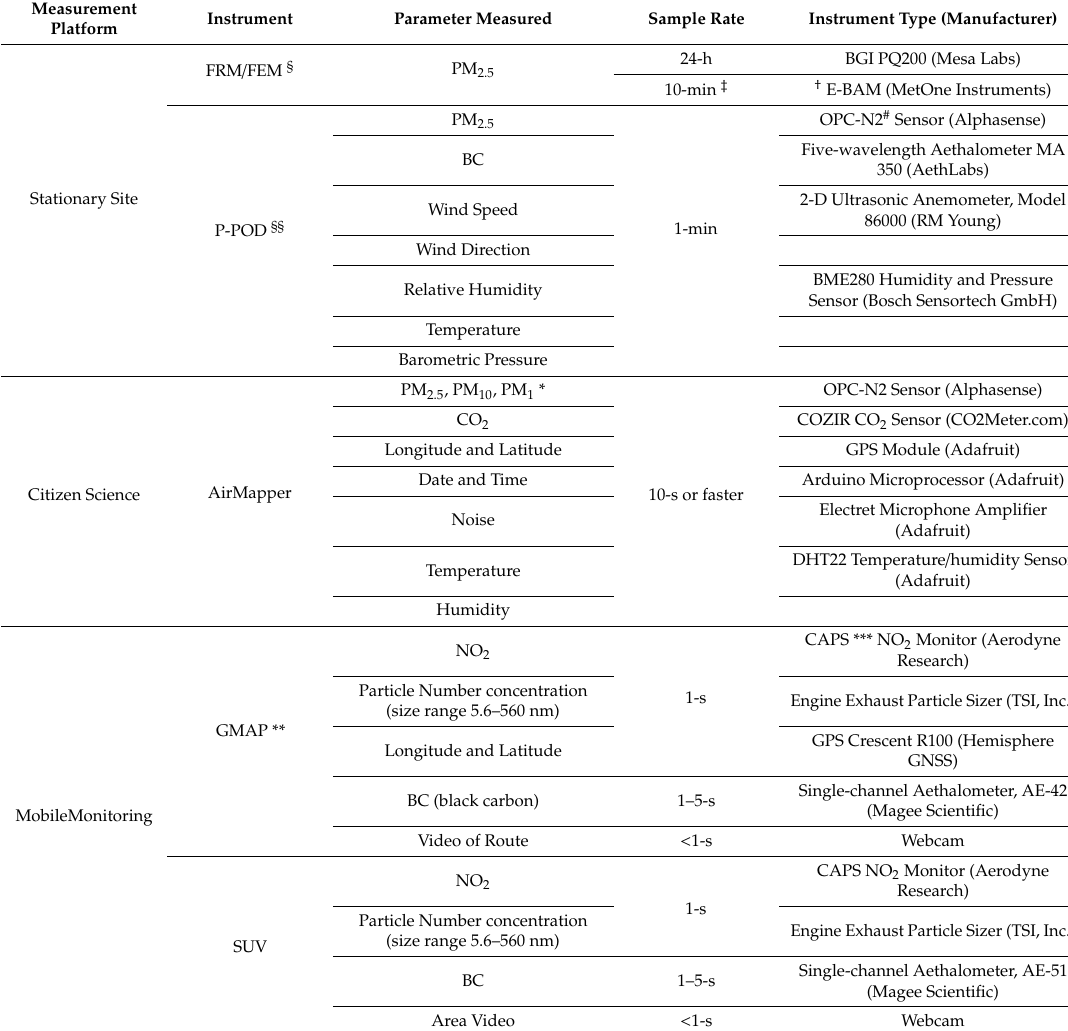
Table 2. KC-TRAQS Instrumentation. The sample interval for all the data is continuous with the exception of the BGI PQ200 instrument, in which the sampling interval was every three